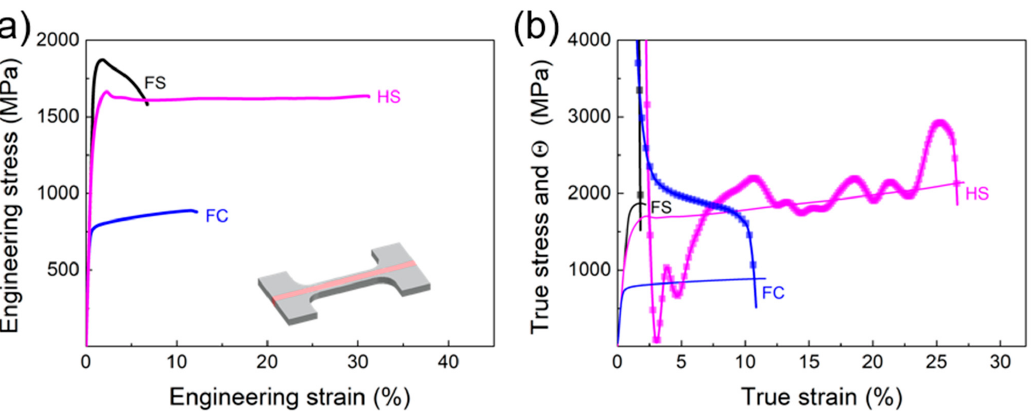
Figure 6. Tensile mechanical behaviors of HS, FC, and FS samples. ( a ) Engineering stress–strain curves. The insert in ( a ) is dog-bone-shaped tensile HS specimen, where the pink area is the weld. ( b ) True stress–strain and strain hardening ( Θ ) behaviors. ( b ) True stress–strain and strain hardening ( Θ )